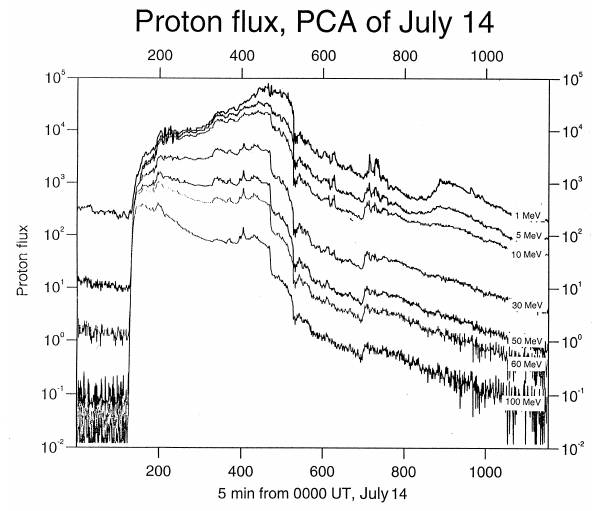
Fig. 4. Integral proton fluxes at energies exceeding 1, 5, 10, 30, 50, 60, and 100MeV during the event which started 14 July 2000, measured by GOES-10 at geosynchronous orbit.